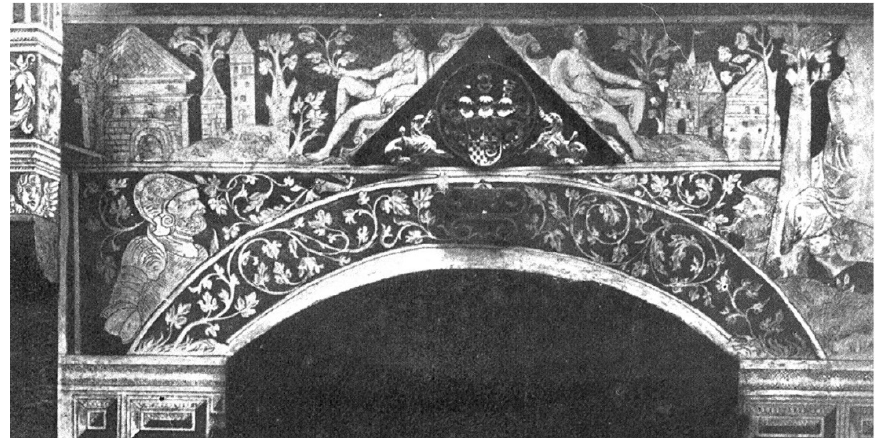
Figure 10. Only a photograph from 1909 has survived of the sgraffiti decorating the gate leading to one of the stalls in Legnica. Source: Hahn (1912, p. 128).